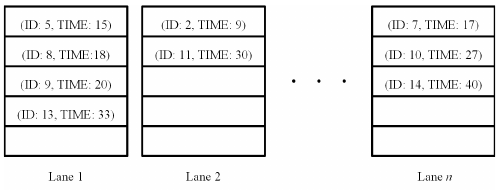
Figure 3. The architecture of